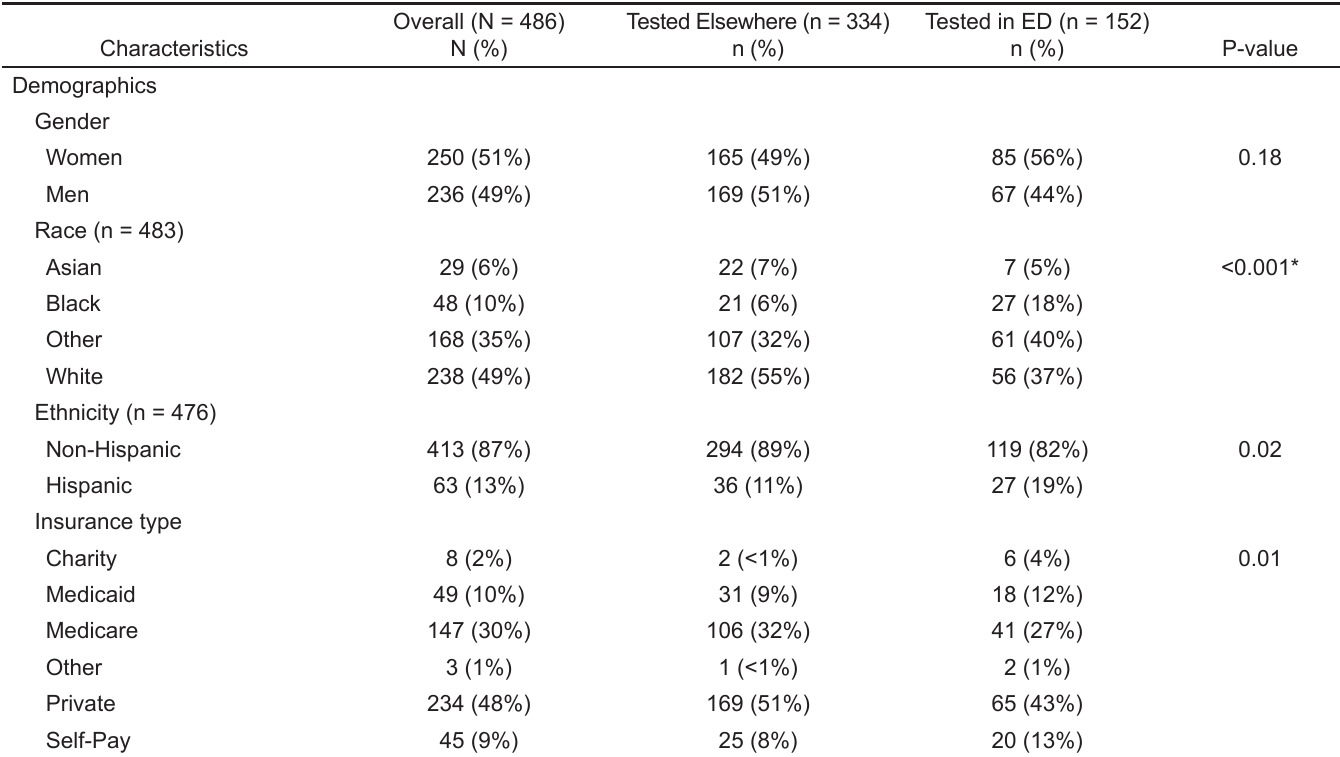
Table 1. Characteristics of patients receiving monoclonal antibody infusion in the emergency department (ED) comparing